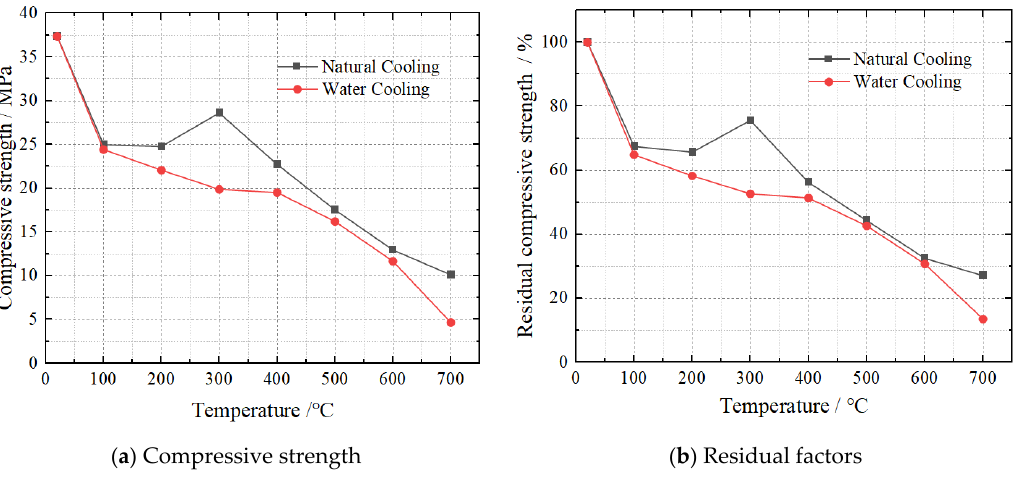
Figure 8. The compressive strength of SCC specimens after heating and